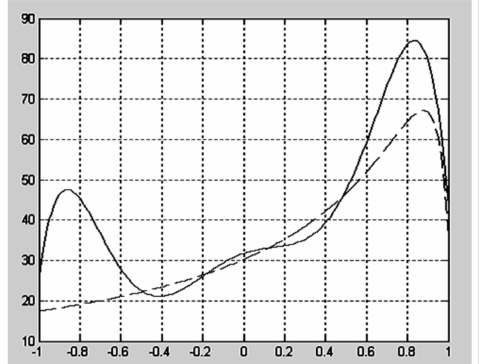
Figure 8. Dependences of the operating device profiles of equal strength (dashed line) and the optimal profile under the conditions of Equations (36) and (38) (solid line).